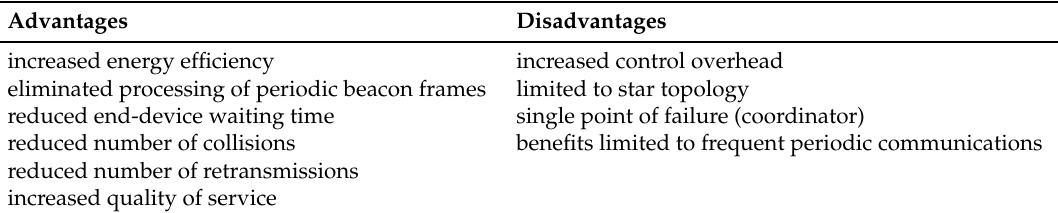
Table 13. Advantages and disadvantages of the EEMIP